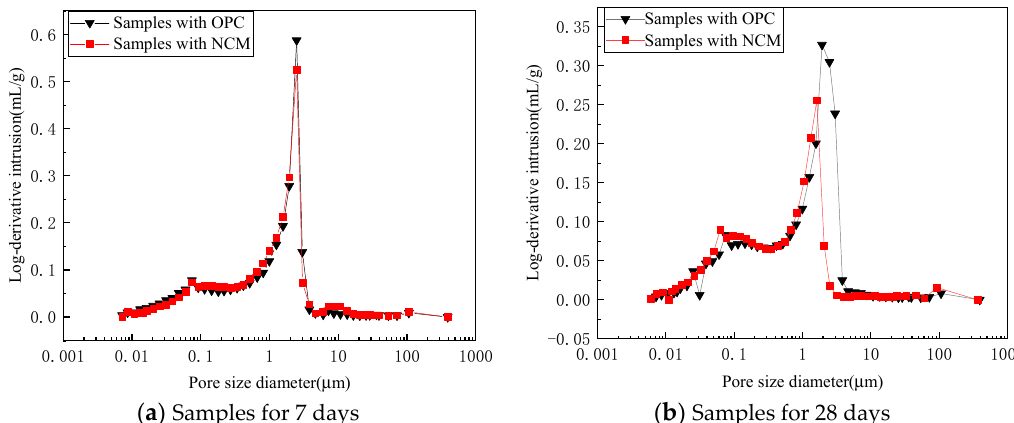
Figure 14. The log-derivative pore volume curves for samples with different cement materials and curing time.